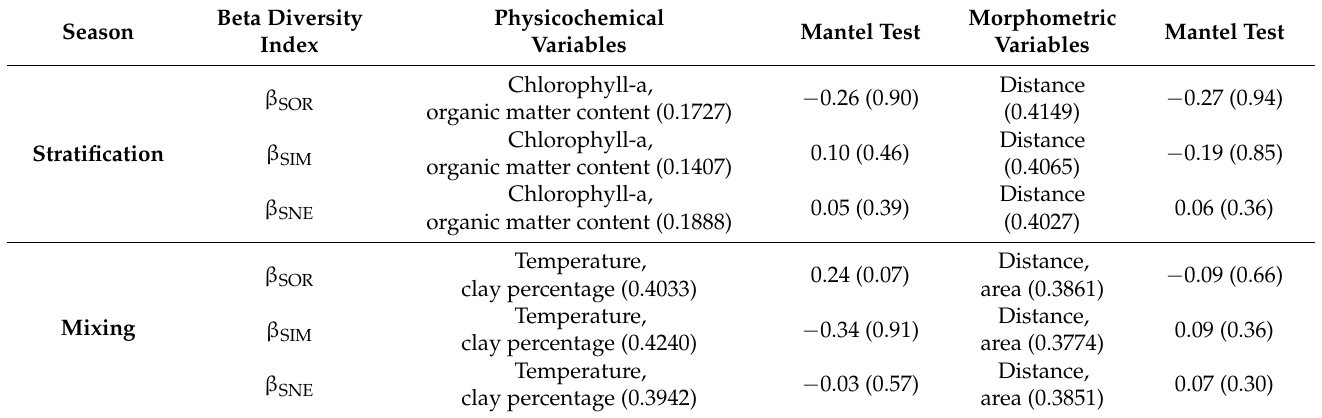
Table 4. Bio-env (correlation values are in brackets) and Mantel test ( p -values are in brackets) results for the three beta diversity components ( β SOR Sorensen, β SIM turnover, β SNE nestedness), water and sediment physicochemical variables and lakes’ morphometric variables in the stratification and mixing